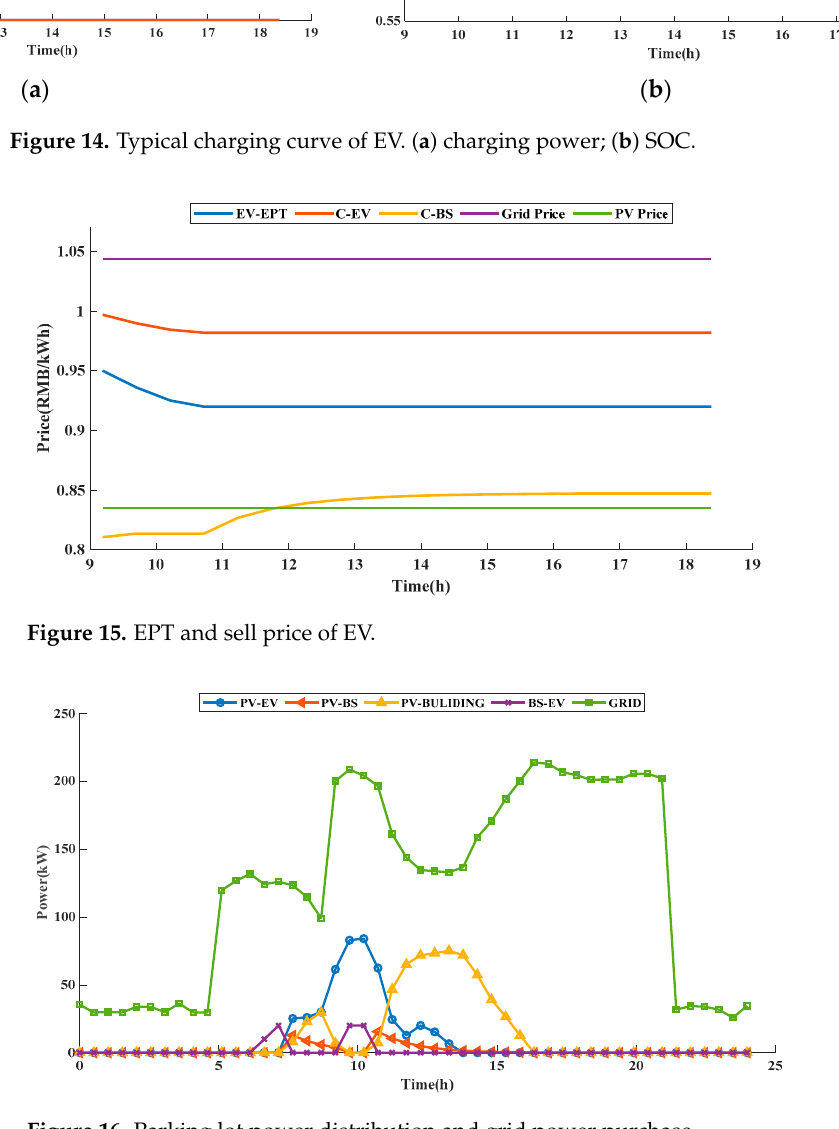
Figure 16. Parking lot power distribution and grid power purchase.